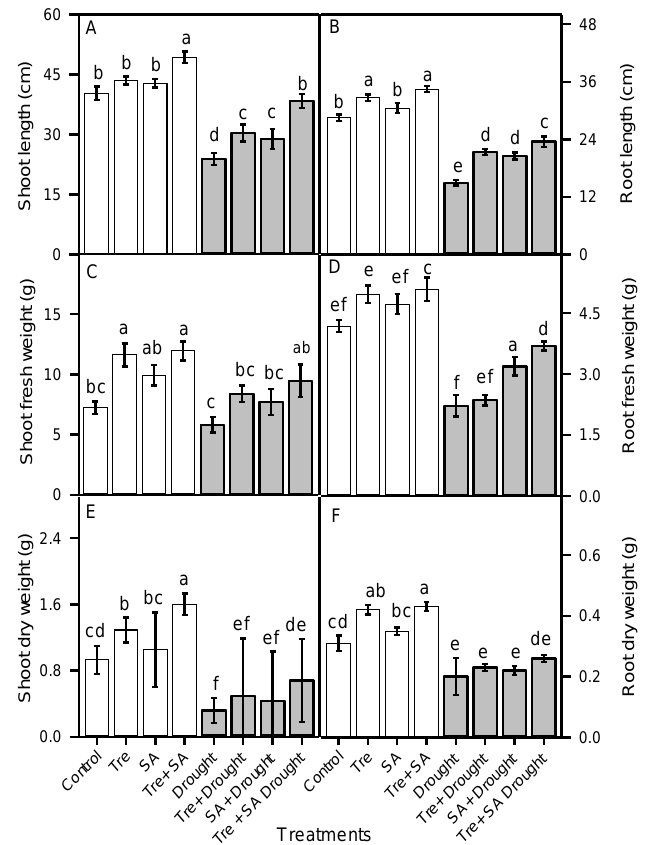
Figure 1. Shoot and root lengths ( A,B ), fresh and dry weight ( C–F ), of sweet basil ( Ocimum basilicum ) after foliar application of trehalose and salicylic acid individually or in combination during drought stress. One month old seedlings were watered to 100% (control, open bars) or 60% (drought, filled bars) field capacity (FC) for 20 days. Trehalose (Tre) and/or salicylic acid (SA) were then applied twice with a 5 day interval between applications. The watering conditions were maintained for an additional 2 weeks until plants were harvested. Data are the means ± SE ( n = 6). Different letters above the bars represent significant differences according to Duncan’s multiple-range test at the p < 0.01 level. Leaf Chl- a concentration in plants grown at 100% FC increased by 6%, 4%, and 14% after application of Tre, SA, and Tre + SA, respectively (Table 1). Drought stress caused a decline in Chl- a by 43% compared to the control. However, supplementing drought- stressed plants with Tre or SA increased Chl- a concentration by 43% and 28%, respec- tively, relative to untreated drought-stressed plants. The combined application of Tre +